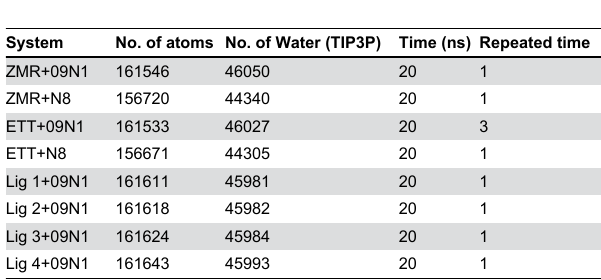
Table 1. Detailed information of all the MD simulation